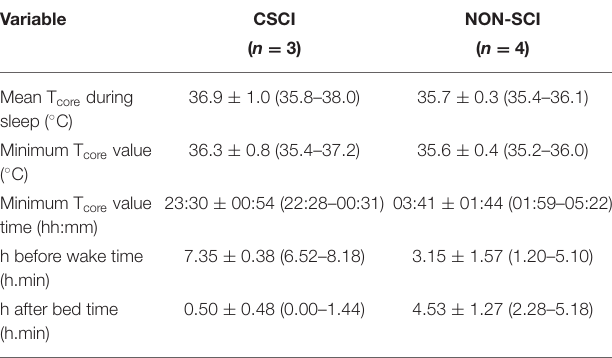
TABLE 3 | Night-time parameters of T core .